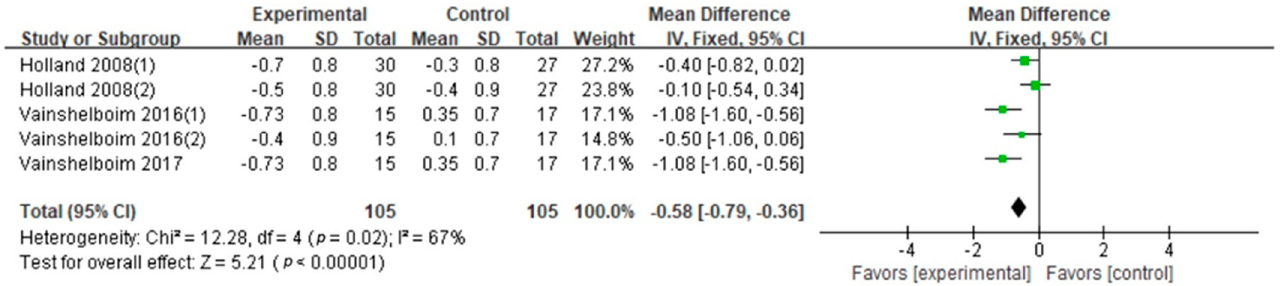
Figure 8. mMRC. Notes: Symbols: for single studies, the squares indicate the mean difference, and the relative size of the square is an indication of the weighting of this study towards the overall effect. The endpoints of the horizontal lines are the upper and lower 95% confidence intervals. The large diamonds represent the summed data for the subgroups and all studies included in the meta-analysis; the midpoint of the diamond indicates the mean difference, whereas the endpoints are the upper and lower 95% confidence intervals. Abbreviations: 95% CI, 95 percent confidence interval; IV, inverse variance; SD, standard deviation. If an included study reported results for different durations, each different duration was treated as a separate trial [51]. Vainshelboim 2016 (1) represents a study with a 3-month exercise duration. Vainshelboim 2016 (2) represents a study with an 11-month exercise duration. Holland 2008 (1) represents a study with a 2.25-month exercise duration. Holland 2008 (2) represents a study with a 6.5-month exercise duration. Perez-Bogerd 2018 (1) represents a study with 3-month exercise duration. Perez-Bogerd 2018 (2) represents a study with a 6-month exercise duration. Perez-Bogerd 2018 (3) represents a study with a 12-month exercise duration.